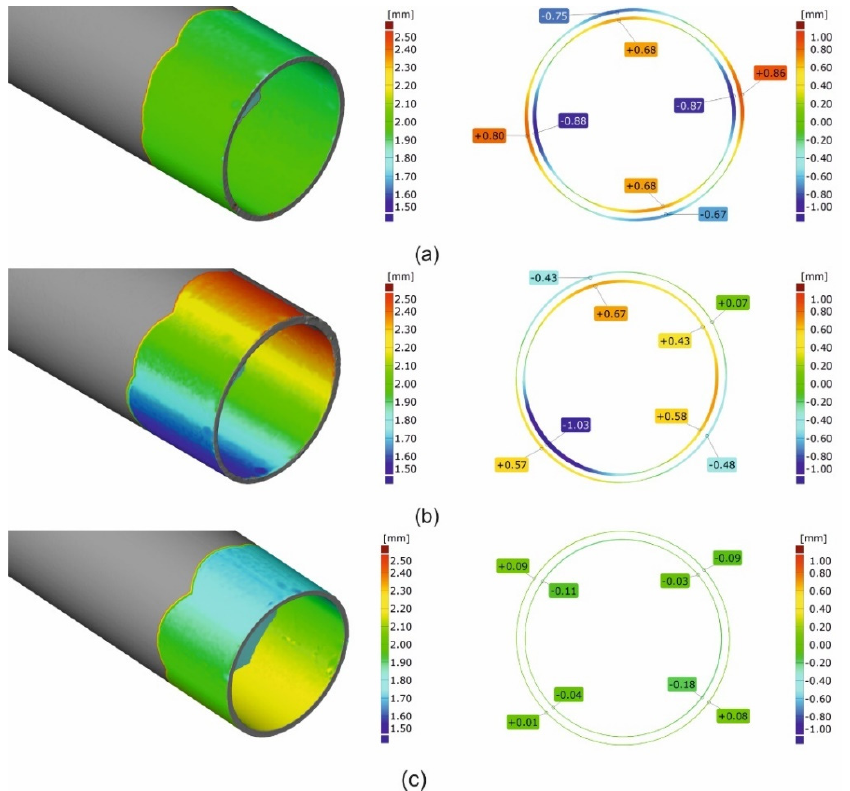
Figure 19. Results of optical scanning of the tubes of Ø50 × 2 mm: coloured maps of deviations for tubes extruded from 7021 alloy with using 2-hole die 1 ( a ), 2-hole die 2 ( b ) and 2-hole die 3 ( c ) (wall thickness on the left and roundness deviations on the right).